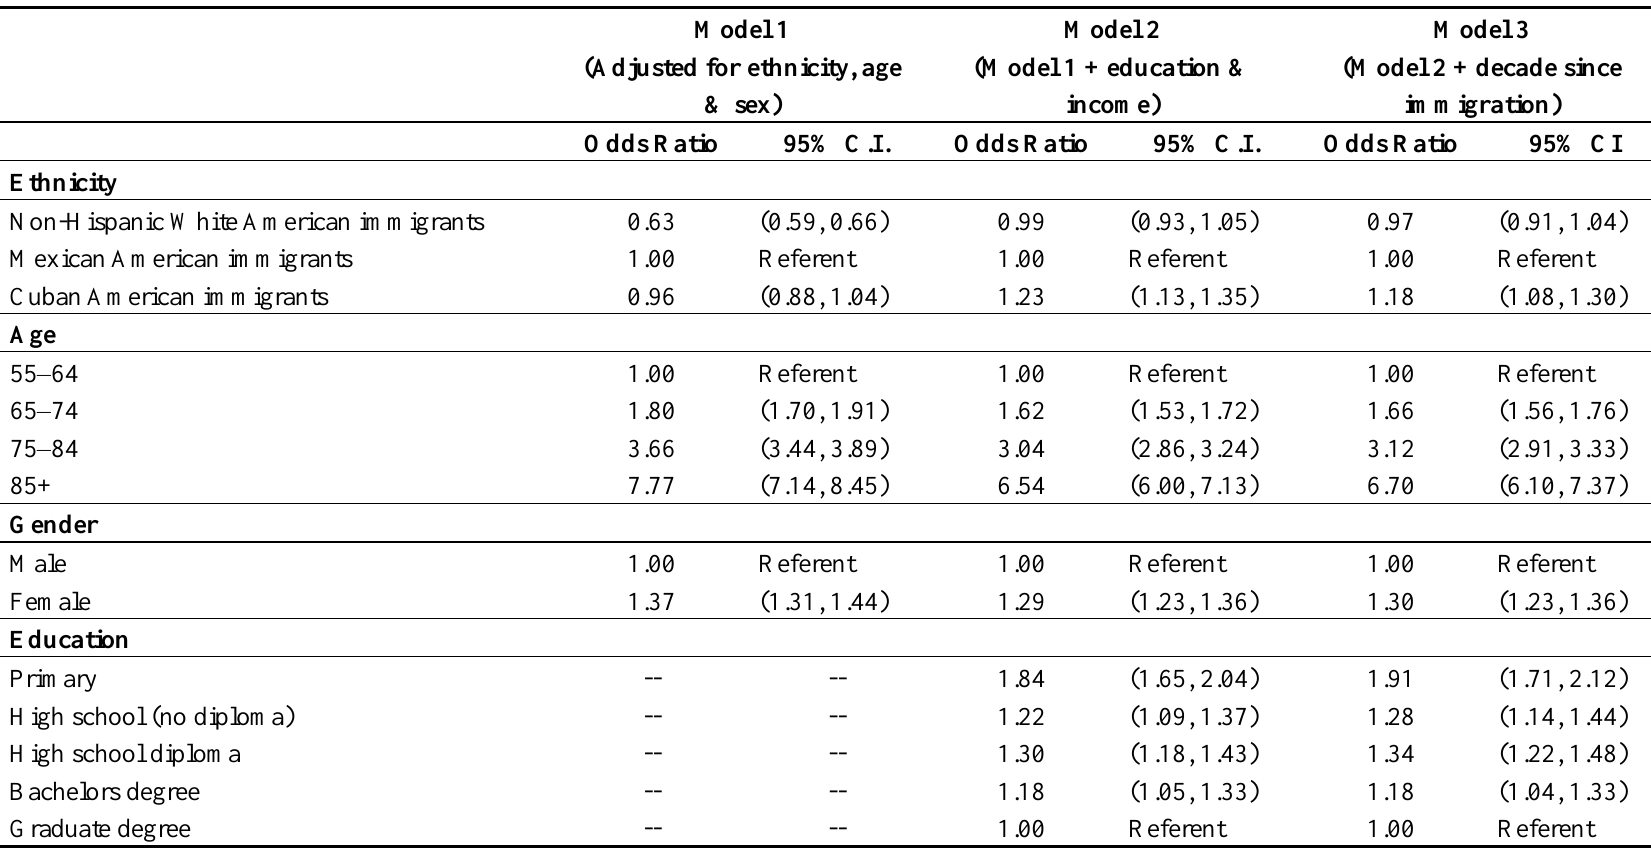
Table 6. Logistic regression analyses of functional limitations status for Mexican American immigrants, Cuban American Immigrants & non-Hispanic White immigrants aged 55 and